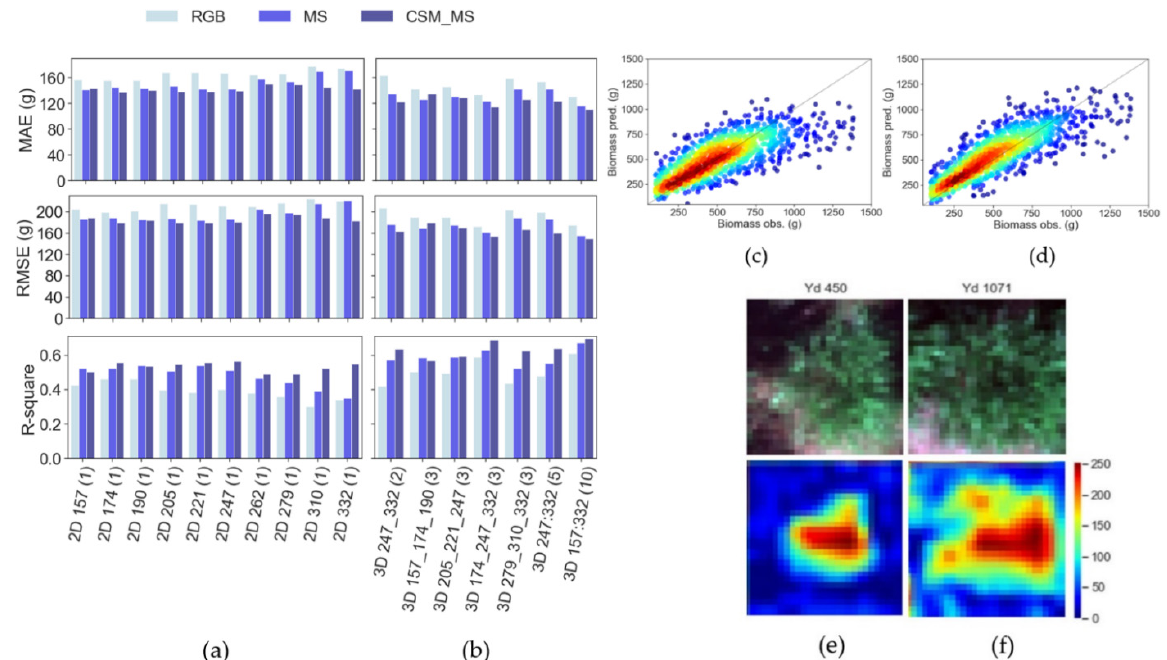
Figure 6. Evaluation of biomass yield prediction in testing data for ( a ) 2D models by DAP and ( b ) 3D models by number of time-frame sequences via the MAE, RMSE, and R 2 metrics. Observed and predicted values for the best ( c ) 2D models and ( d ) 3D models for testing datasets with low- (blue) to high-density (red) sample distribution. Example RGB image chips and activation maps for ( e ) low- and ( f ) high-biomass plants from the 2D-based model of aerial data collected on DOY 279. The level of activation of the deepest CNN layers in the images is represented by low (blue), intermediate (yellow), and high (red) values on a 0–255 scale.